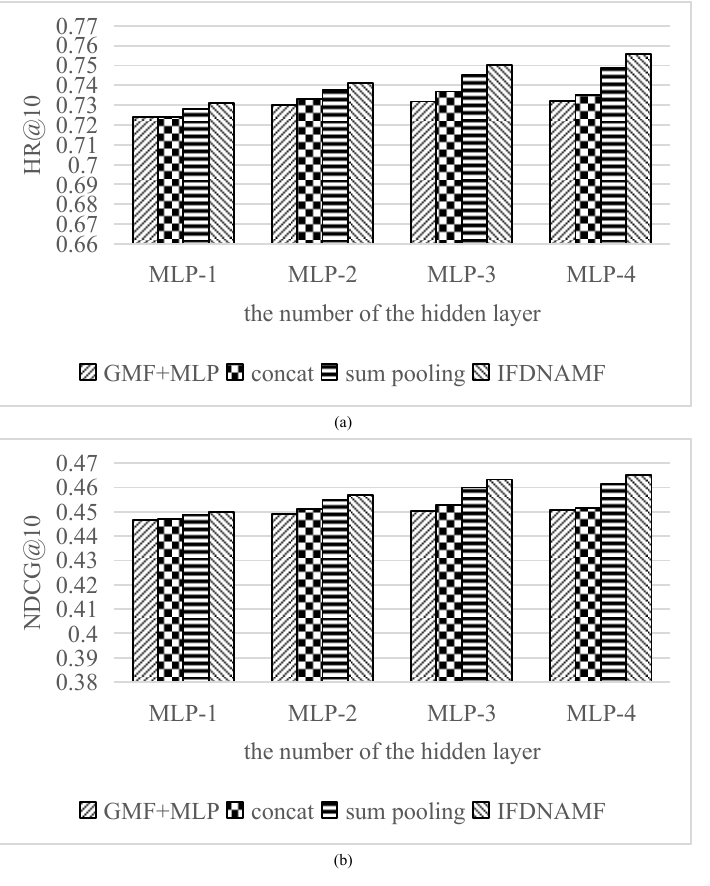
Figure 4. The HR@10 and NDCG@10 of models with different layers on MovieLens. ( a ) HR@10. ( b )